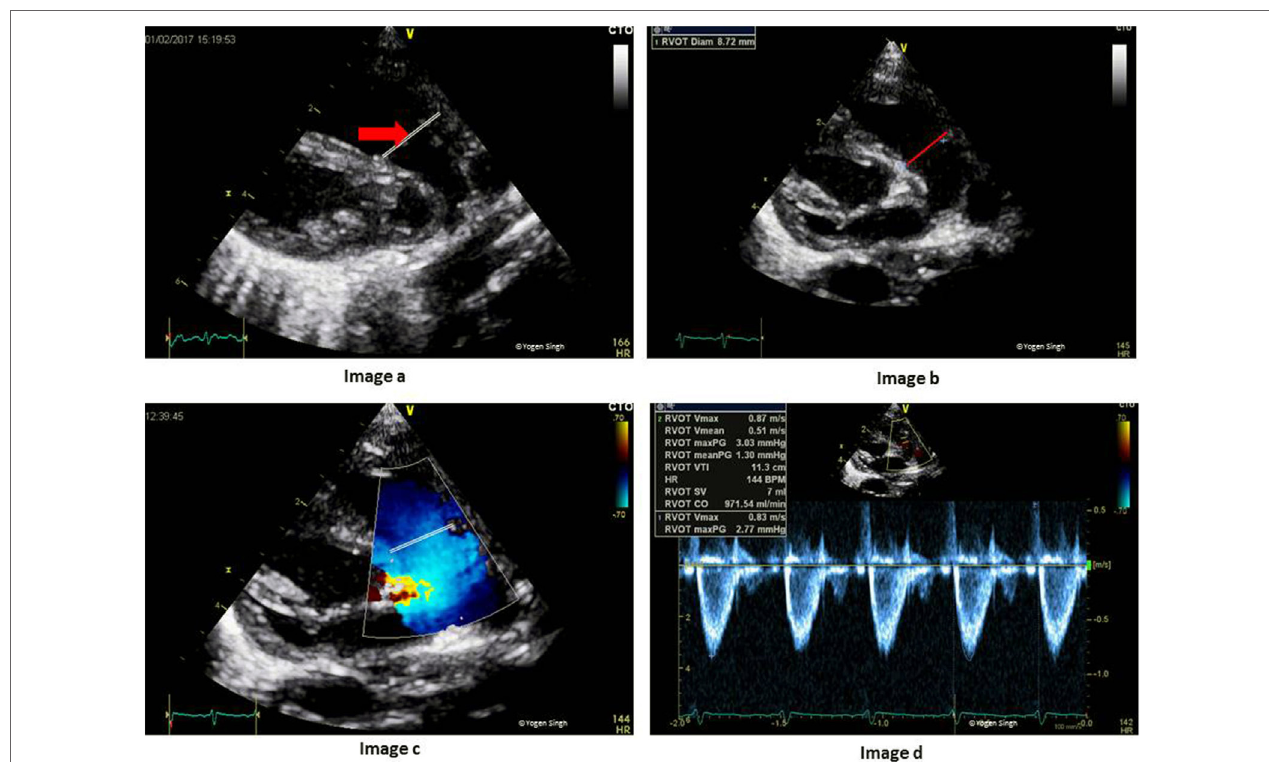
FiGURe 11 | Assessment of right ventricular output (RVO) on echocardiography. Image a shows RV outflow tract (red arrow) and image b with measurement of PV annulus (red line) at the hinge point of PV valve. Image c shows RV outflow tract and the site for PW Doppler to measure VTI (red line showing PW sample gate). Image d shows RVO in milliliters per minute. PV, pulmonary valve; PW, pulse wave; RV, right ventricle; VTI, velocity time